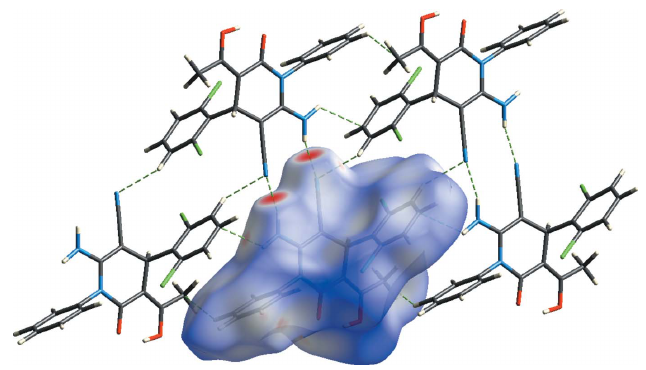
Figure 4 Hirshfeld surface of the title compound mapped with d norm .